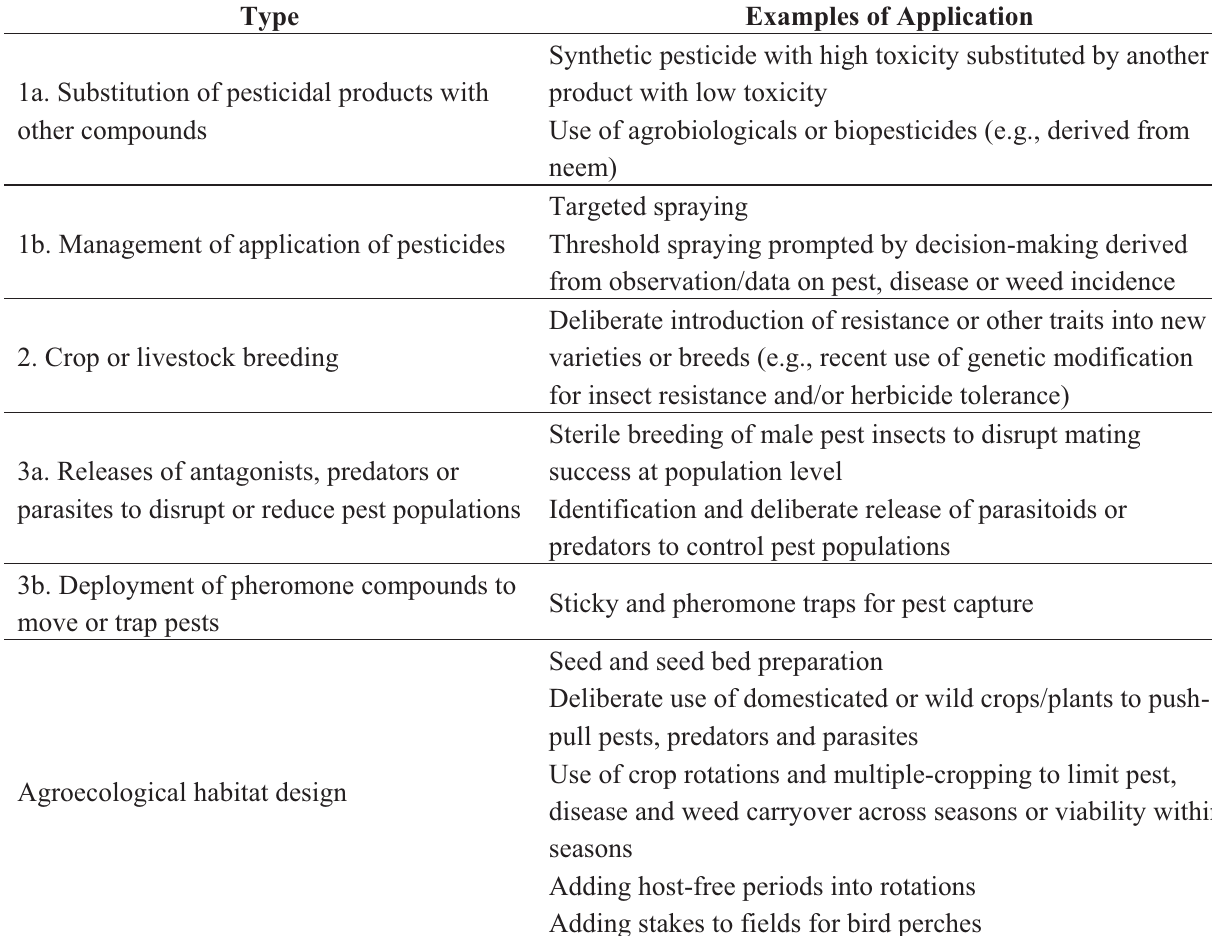
Table 5. Typology of